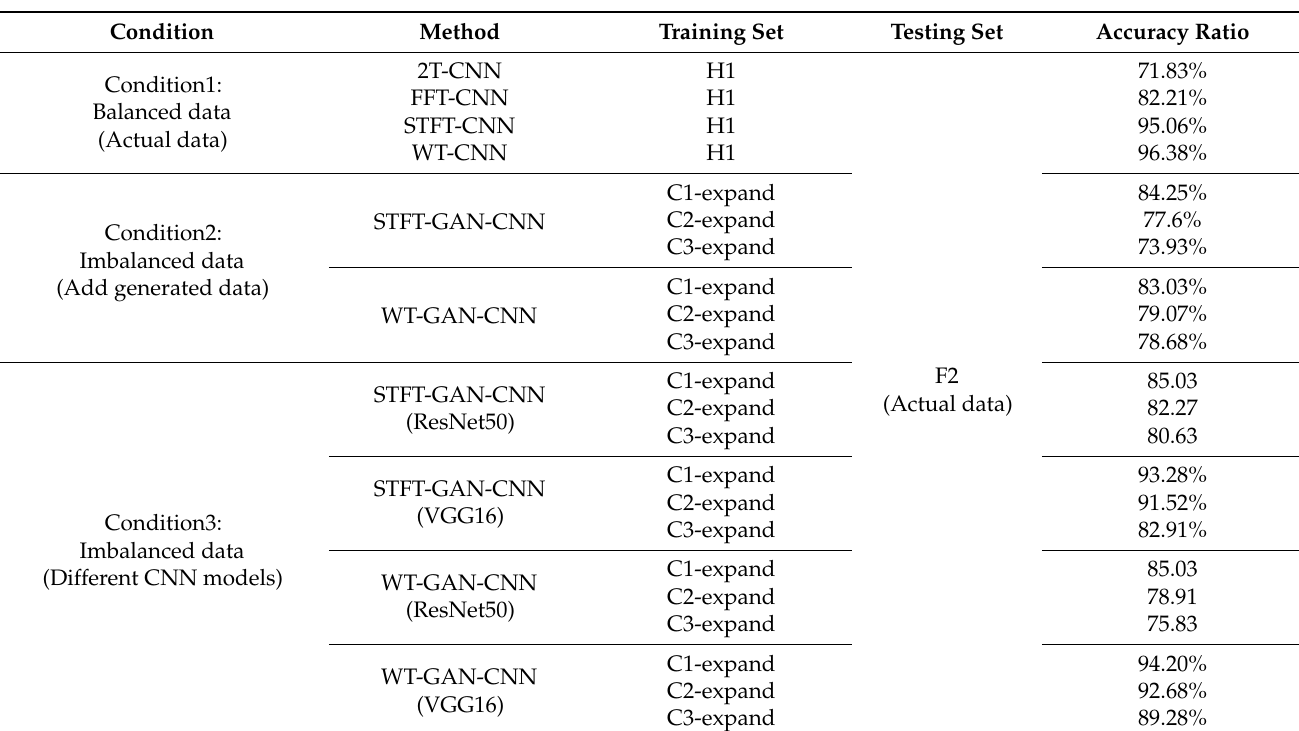
Table 12. Comparison of accuracy of data augmentation